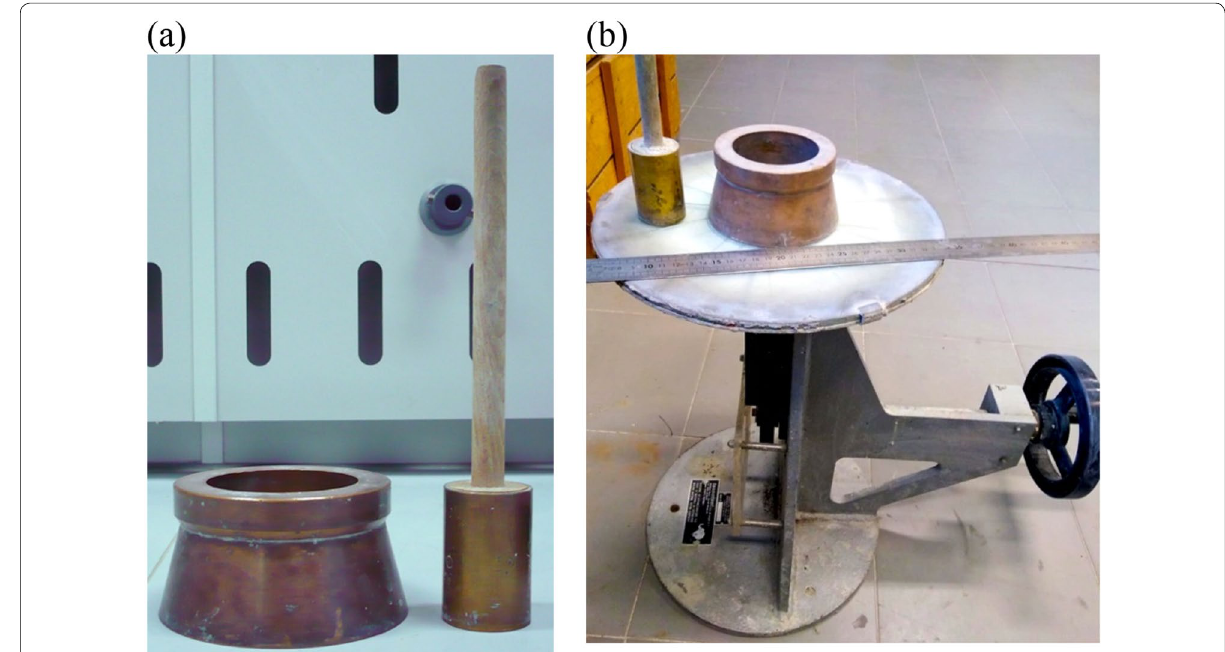
Fig. 3 Device used for workability investigation: a truncated conical mould and b jolting device.